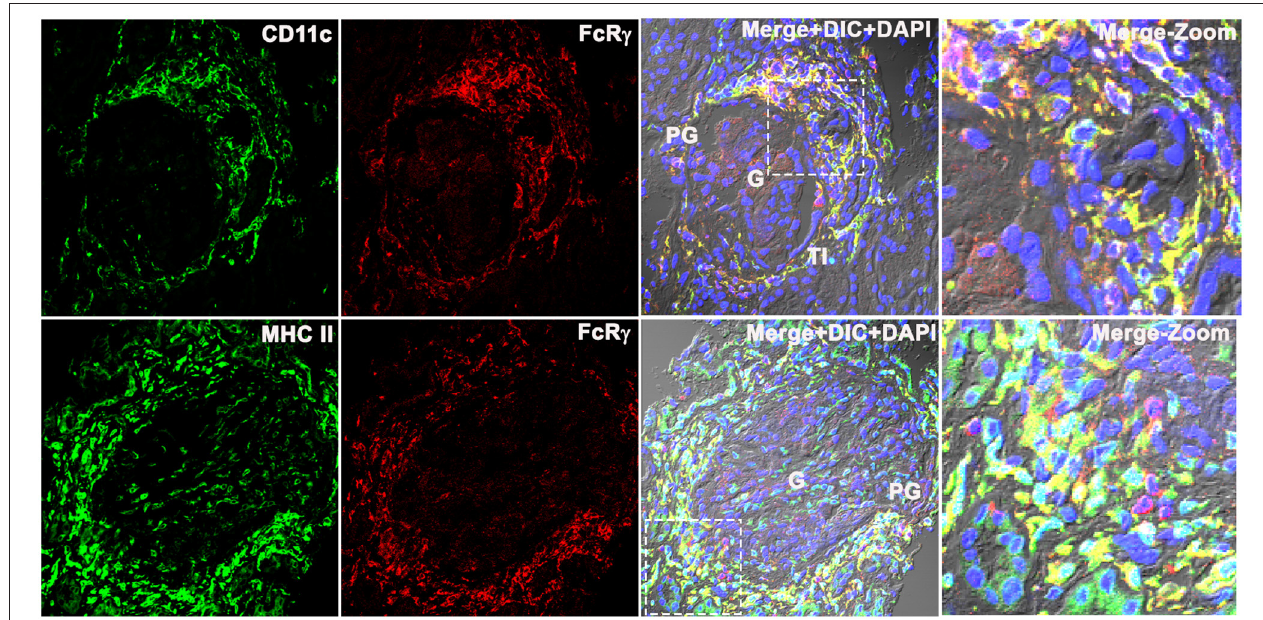
FIGURE 4 | Fc receptor gamma chains colocalize with dendritic cell markers CD11c and MHCII in human LN kidney. Three color IF images that are representative of the 3 human LN kidneys showing colocalization of CD11c (labeled using anti-CD11c antibody followed by Alexa-488 dye conjugated secondary antibody that shows green emission color in confocal microscopy (green) (top row) with FcR γ labeled using anti-FcR γ antibody followed by Alexa-594 conjugated secondary antibody that shows red emission color in confocal microscopy (red). The bottom row shows the colocalization of MHC II labeled using anti-CD11c antibody followed by Alexa-488 dye conjugated secondary antibody that shows green emission color in confocal microscopy (green) with FcR γ labeled using anti- FcR γ antibody followed by Alexa-594 conjugated secondary antibody that shows red emission color in confocal microscopy (red). The third column shows the colocalization of red and green as yellow in the first 2 columns along with DIC and DAPI staining of nuclei (blue). The fourth column shows the zoomed image of the third column highlighted using a dotted